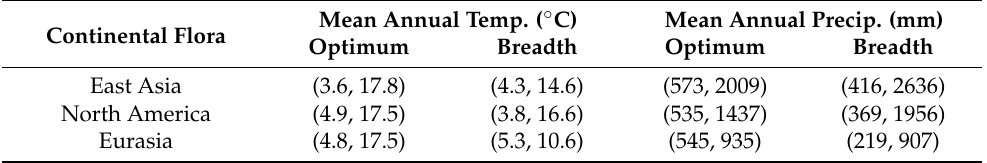
Figure 2. Maxent environmental niche model (ENM) output for two taxa in Section Palmata. ( A , D ) Prediction maps indicate locations with a high (green) to low (red/white) probability of occurrence. Actual, thinned occurrence points (black) and training area under the curve (AUC) are also provided. ( B , E ) True vs. false positive curves used for k-fold model validation along with median testing AUC ( N = 10). ( C , F ) Precipitation seasonality (bio15, dimensionless coefficient of variation) was an especially important environmental variable predicting the distribution of both taxa. Curves indicate the likelihood of occurrence over a range of values of precipitation seasonality. Table S3 and Figures S2 and S3 give model validation data, response curves, and prediction maps, respectively, for all maple taxa. Table 1. Minima and maxima of optima and breadths for two environmental axes of the niches of temperate maple taxa. See Table S5 for niche optima and breadths on a per-taxon